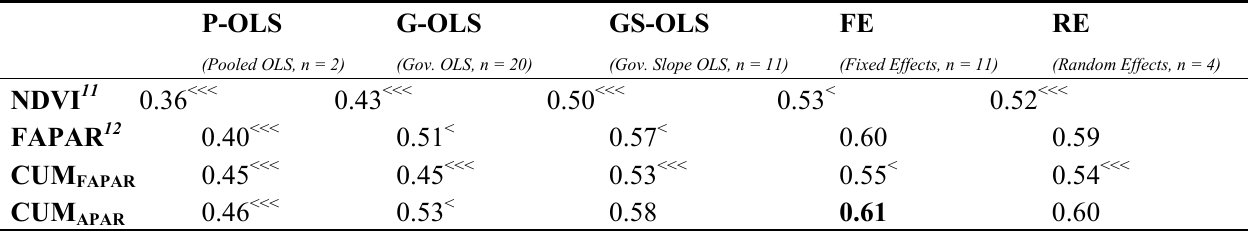
Table 2. Jackknifed (cid:1844) (cid:3050)(cid:3036)(cid:3047)(cid:3035)(cid:3036)(cid:3041)(cid:2870) with BP in rows and models in columns. R 2 that are significantly lower than the higher value (in bold) at 10%, 5% and 1% are respectively indicated by superscripts < , << and <<< . n indicates the number of parameters to be